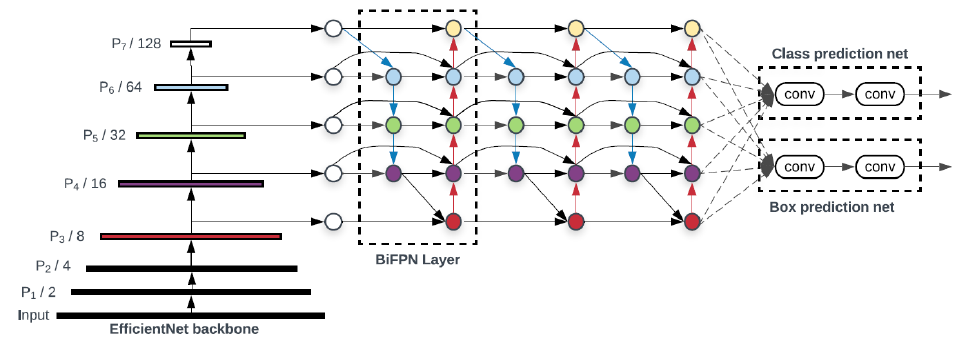
Figure 5. EfficientDet architecture